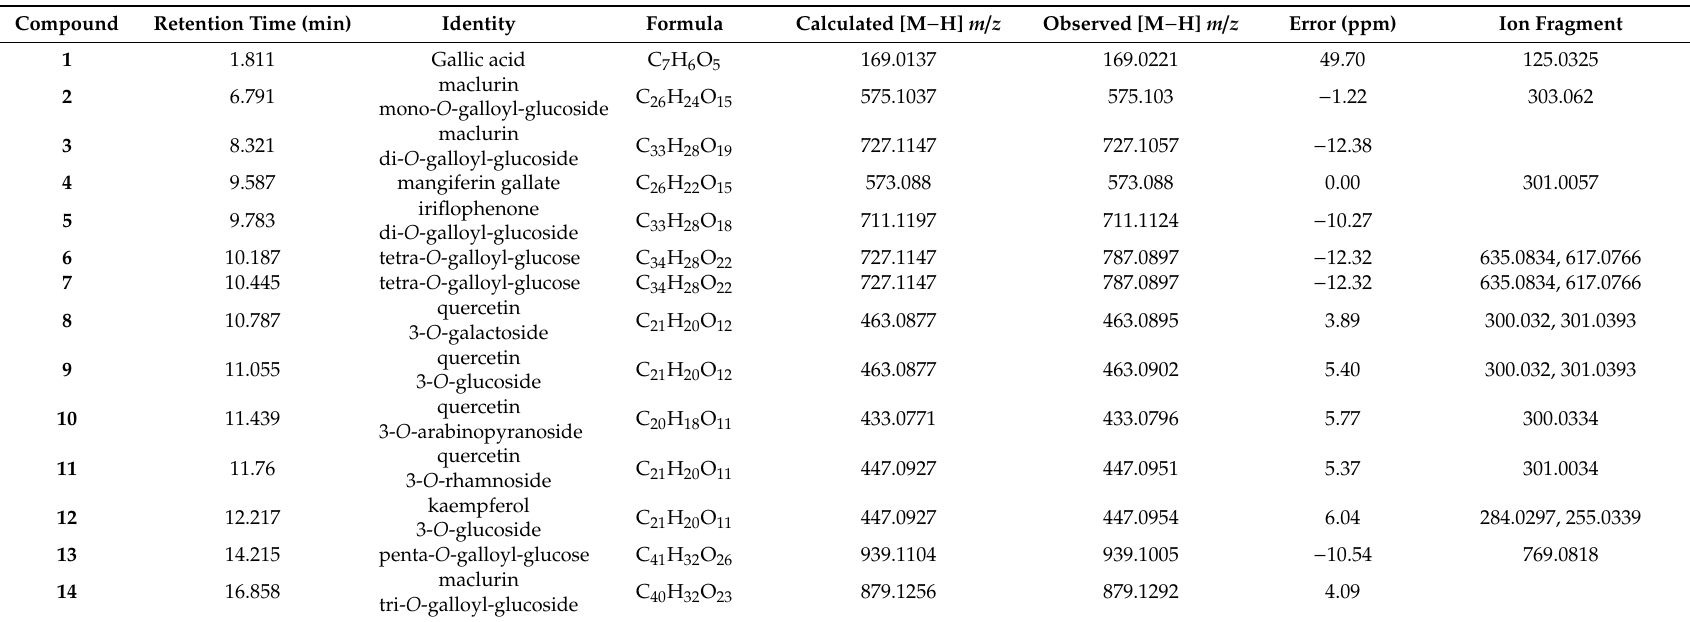
Table 5. Identification of polyphenolic compounds in Kensington Pride mango pulp by UPLC-Q-TOF-HRMS n